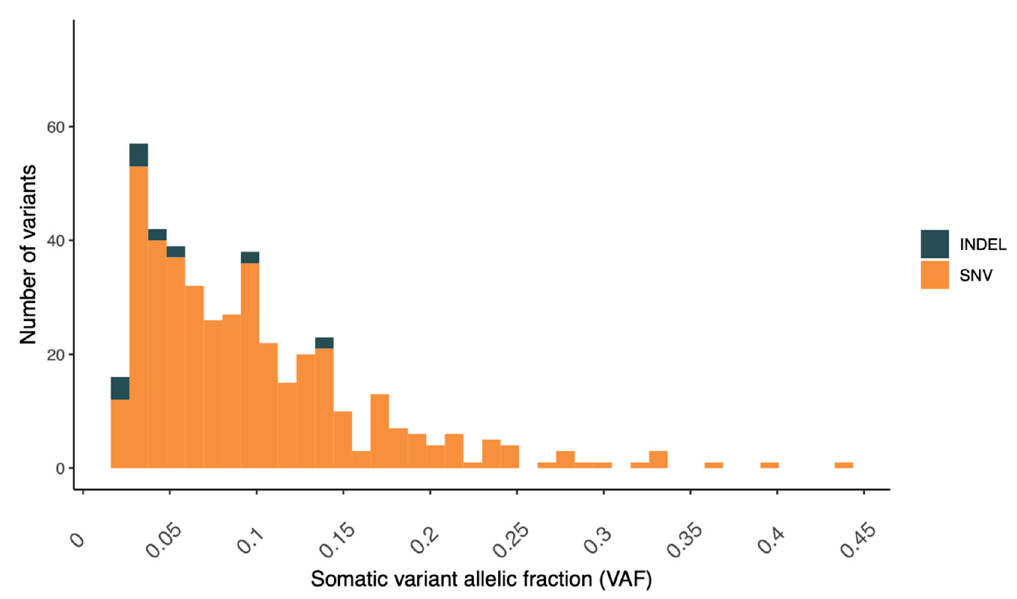
Figure 3. Distribution of the variant allelic fraction for somatic variants (SNVs/InDels) detected in the prostate tumor case.